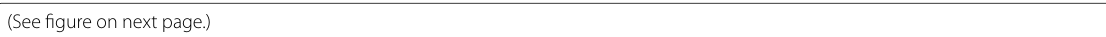
(See figure on next Fig. 4 The effect of cross-interaction among shaking speed, culture temperature and pH on total number of alive B. mucilaginous. a Response surface plot of effects of interaction between shaking speed and culture temperature on total number of alive B. mucilaginous ; b contour line of effects of interaction between shaking speed and culture temperature on total number of alive B. mucilaginous ; c response surface plot of effects of interaction between shaking speed and pH on total number of alive B. mucilaginous ; d contour line of effects of interaction between shaking speed and pH on total number of alive B. mucilaginous ; e response surface plot of effects of interaction between culture temperature and pH on total number of alive B. mucilaginous ; f contour line of effects of interaction between culture temperature and pH on total number of alive B. mucilaginous